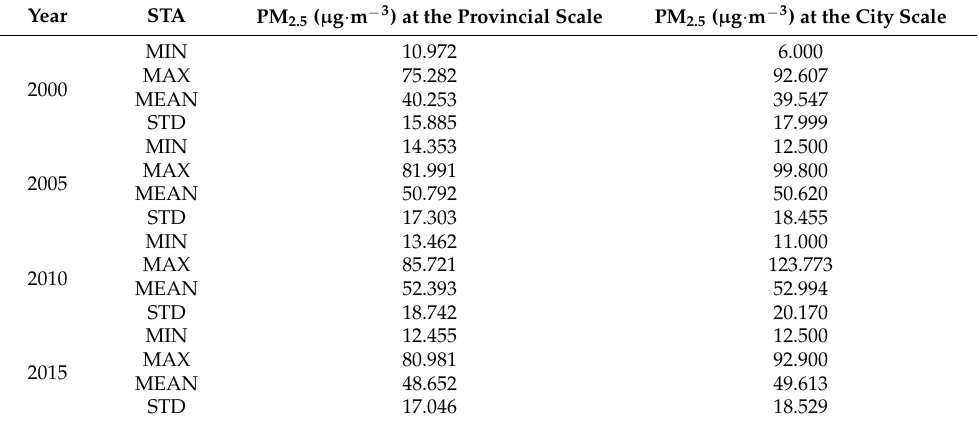
Table 3. Statistics of the dependent variables at different